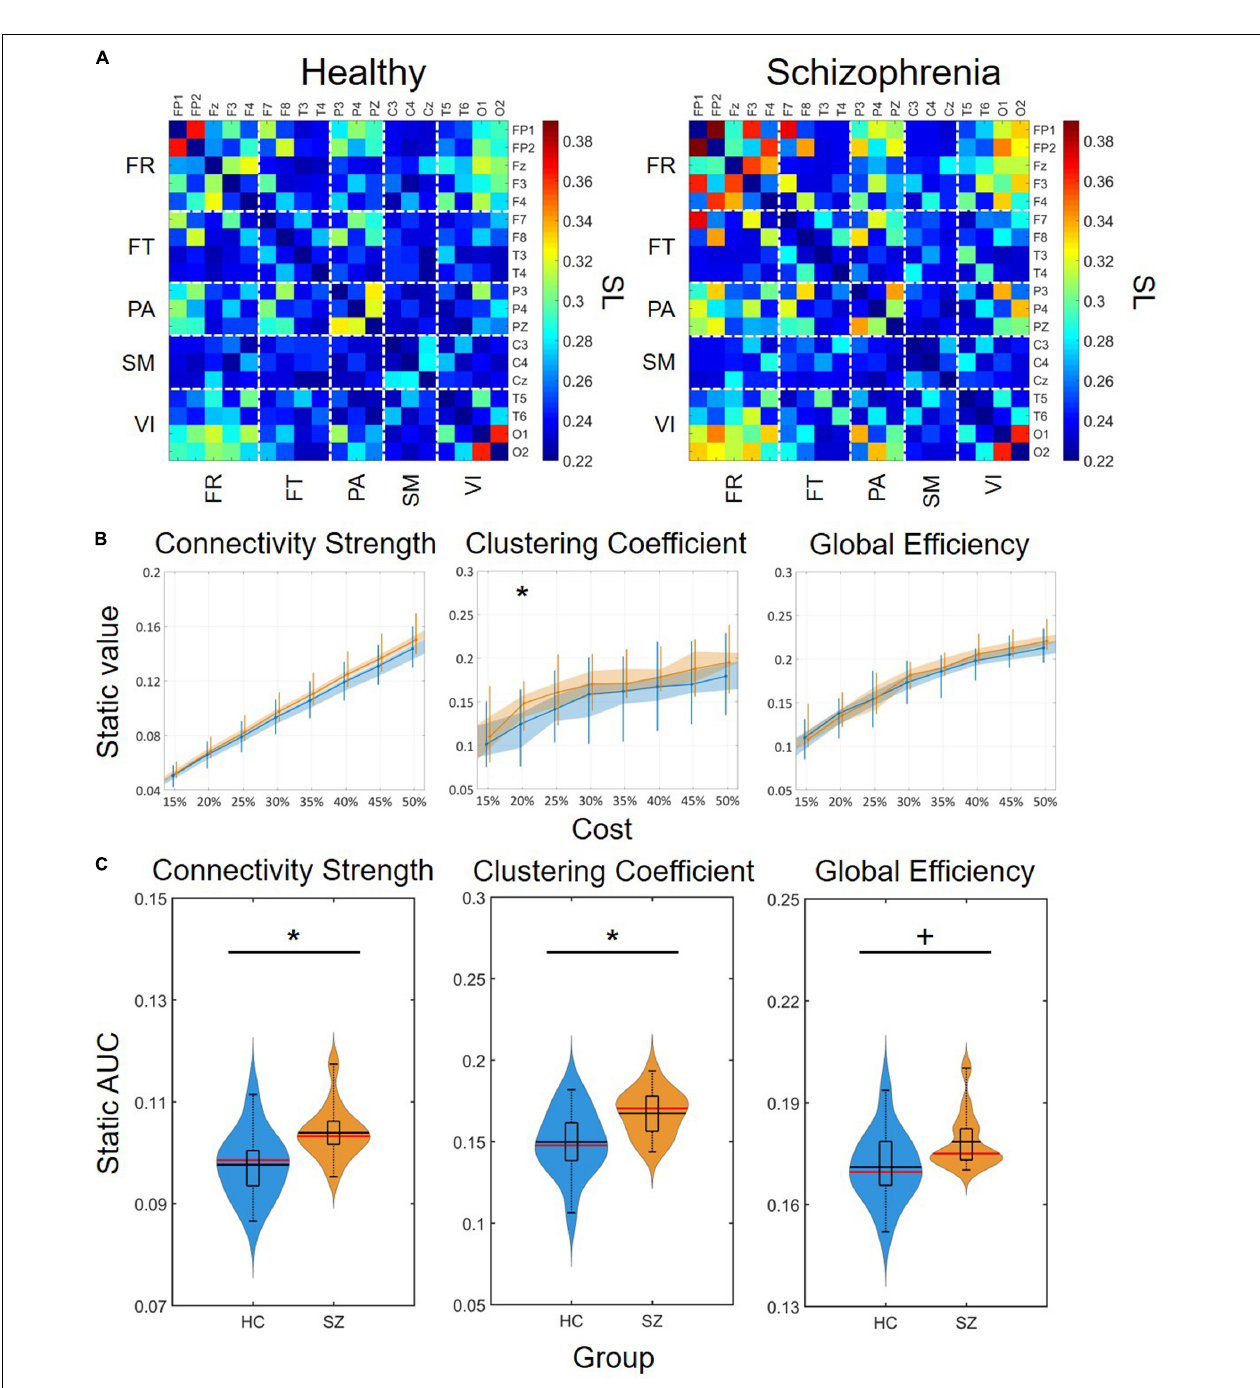
FIGURE 3 | Group-average connectivity matrices and results of static functional connectivity analysis. (A) Group-average static connectivity matrices for healthy controls (left) and patients with schizophrenia (right). For a better comparison, the matrices are in the same color scale. Channels are grouped according to macroanatomical brain regions. (B) Results of the cost-dependent analysis. Data corresponding to healthy controls is marked in blue, while those of patients with schizophrenia are marked in orange. Dots mark median values, the shaded area refers to the 25th and 75th percentiles, and vertical lines range from 10th to 90th percentiles. Asterisk marks significant group difference ( p < 0.05, corrected) acquired with two sample t -test. (C) Violin plots of static FC results for all three network measures. In each violin plot the central black line indicates the mean and the central red line indicates the median. The lower and upper horizontal lines of the rectangle mark the 25th and 75th percentile, respectively, and the outer horizontal lines indicate the 10th and 90th percentile values. The colored areas illustrate the estimated probability density function of the corresponding datasets. An asterisk marks significant group difference ( p < 0.05) identified with two-sample t -test, while a plus sign marks significant difference identified with Mann-Whitney U -test. SL, synchronization likelihood; FR, frontal cortex; FT, frontotemporal regions; PA, parietal cortex; SM, somatomotor cortex; VI, visual cortex; AUC, area under the curve; HC, healthy control; SZ, schizophrenia.